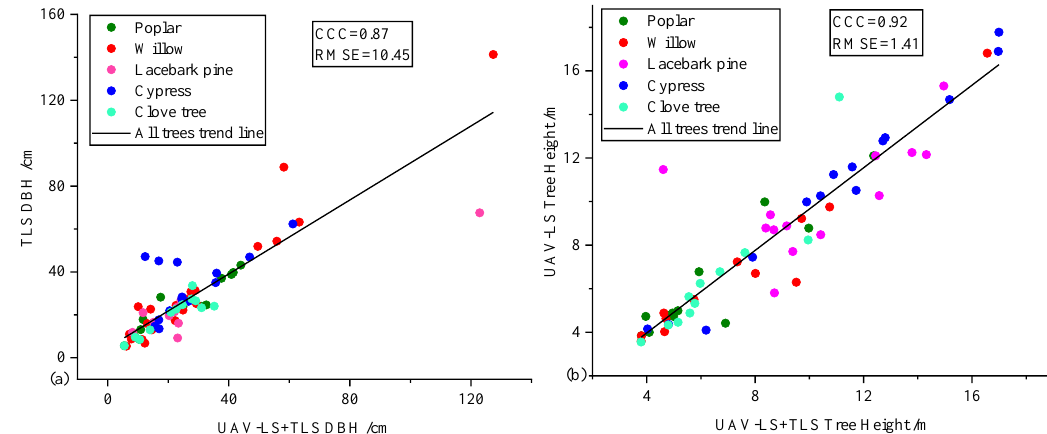
Figure 9. ( a ) The DBH fit for all tree species and ( b ) All tree heights.